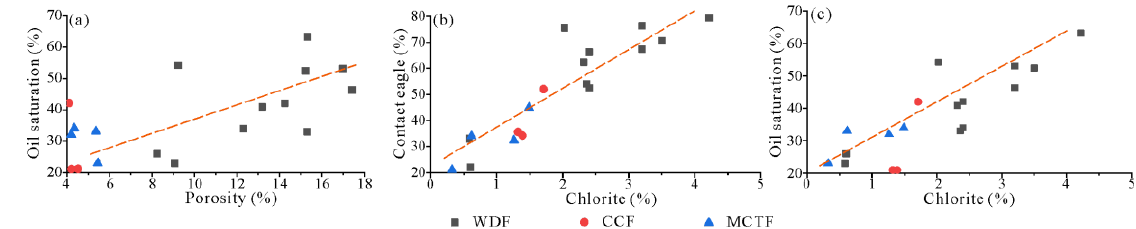
Figure 13. Plots of controlling factors for oil saturation of the reservoir in the Toutunhe Formation. ( a ) Relationship between the oil saturation and porosity; ( b ) contact eagle versus chlorite; ( c ) correlation between oil saturation and chlorite. CCF: carbonate cemented facies; MTCF: matrix-caused tightly compacted facies, WDF: weakly diagenetic reformed facies.